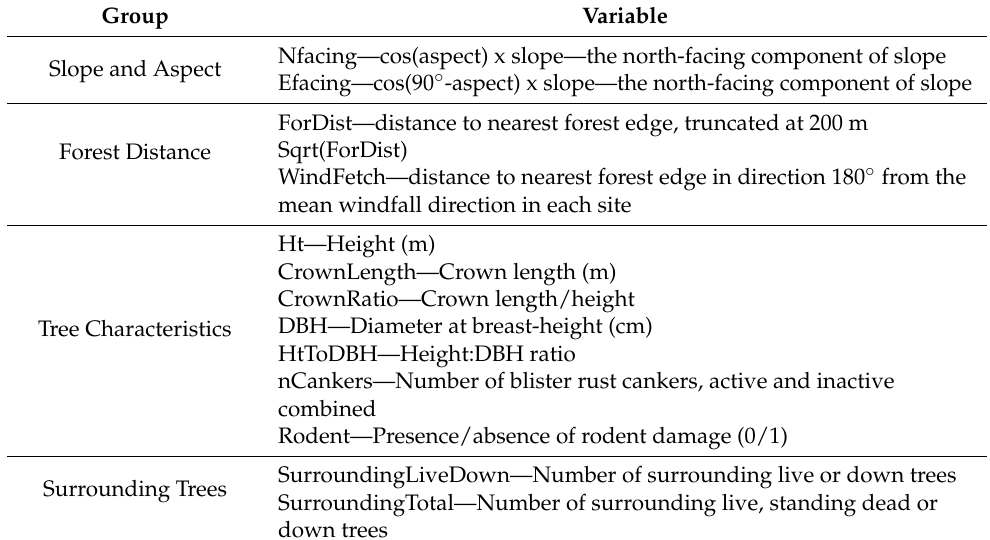
Table 3. Four groups of biophysical variables examined and used in models (underlined) to predict the survival of retained whitebark pine